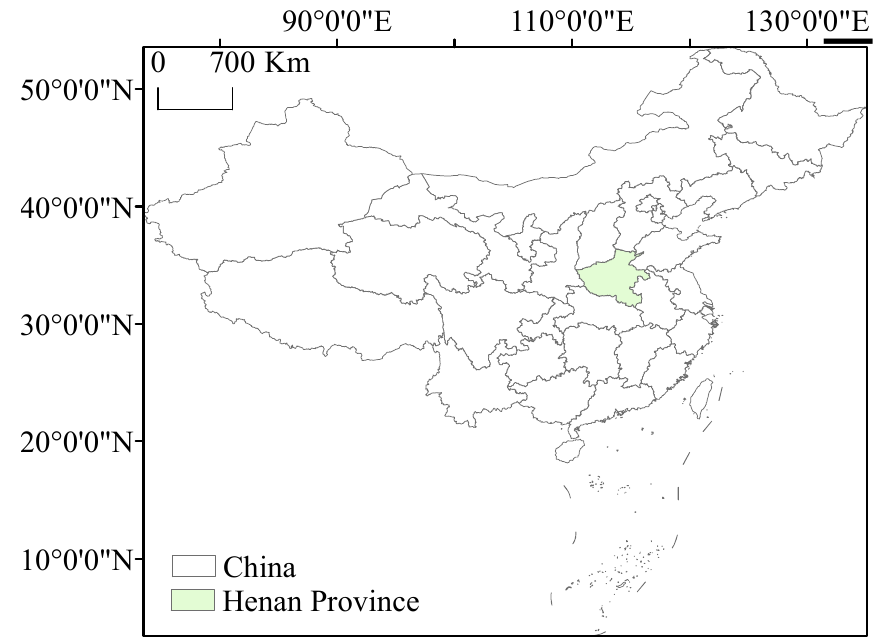
Figure 1. Location of study area in China.